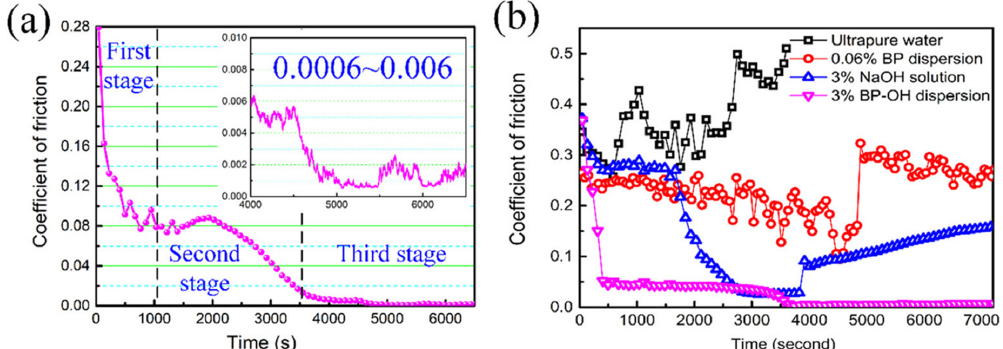
Figure 12. ( a ) Variation in the COF with time using the 7 wt.% BP-OH aqueous solution as the lubricant. The inset is the magnified graph of the COF after the running-in period. ( b ) The comparative plots of the COFs of four different lubricants including ultrapure water, 3% NaOH solution, 0.06% BP Dispersion and 3% BP-OH dispersion. Reproduced with permission from [119]. Copyright 2018 American Chemical Society.